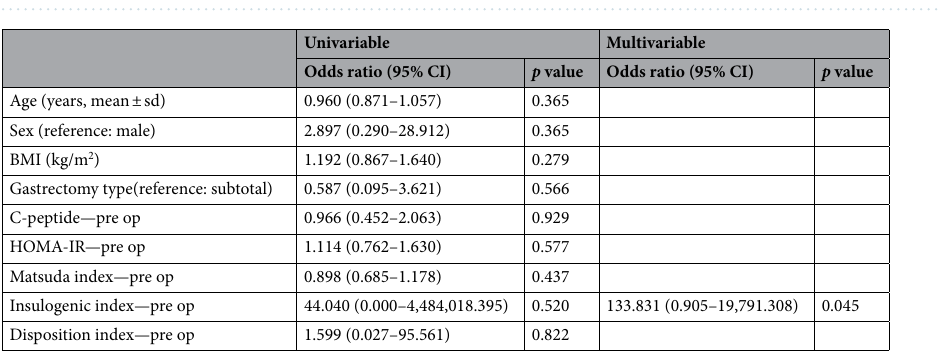
Figure 3. Diabetic index in subtotal long-limb Roux-en-Y gastrectomy patients (n = 36). * P value: preoperative versus 1-year postoperative value in the non-remission group. ** P value: preoperative versus 1-year postoperative value in the remission group.